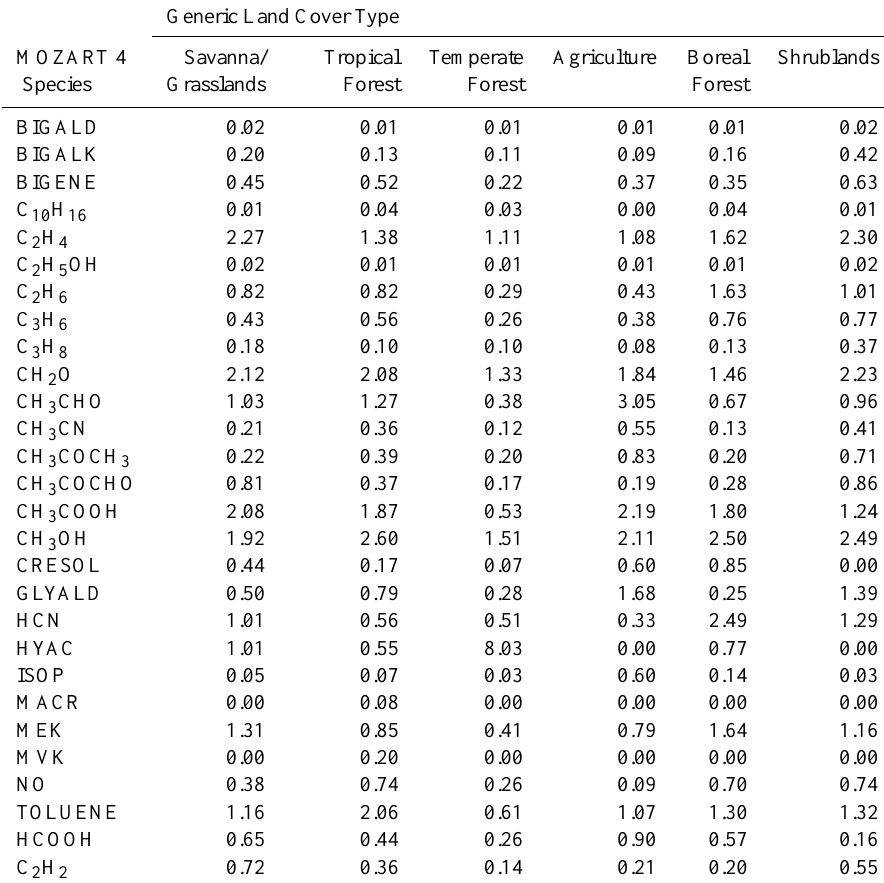
Table 3. Factors to convert NMOC Emissions (kgday − 1 ) to MOZART-4 chemical species (moles-speciesday − 1 ) for each generic land cover class in which a fire burns. See Emmons et al. (2010a) for description of lumped species.